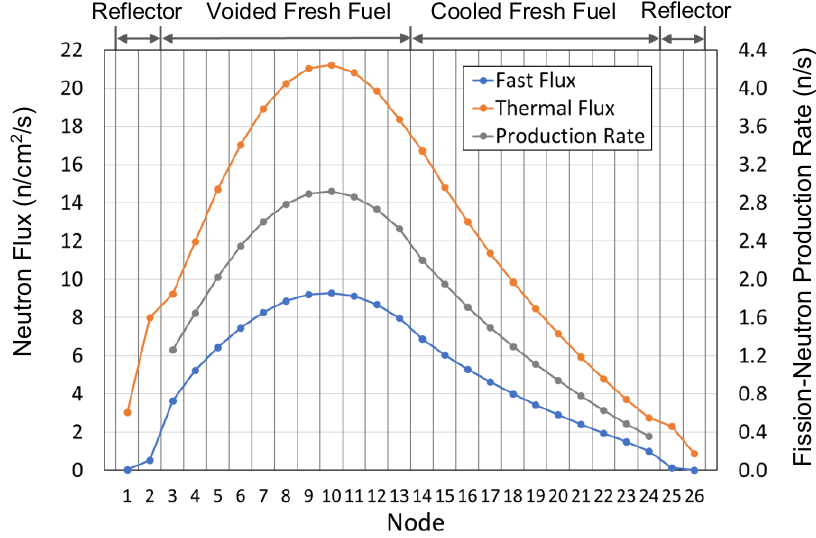
Figure 5. Reference Node-averaged Neutron Fluxes and Node-integrated Fission-Neutron Production Rates at Transient Time 0.5